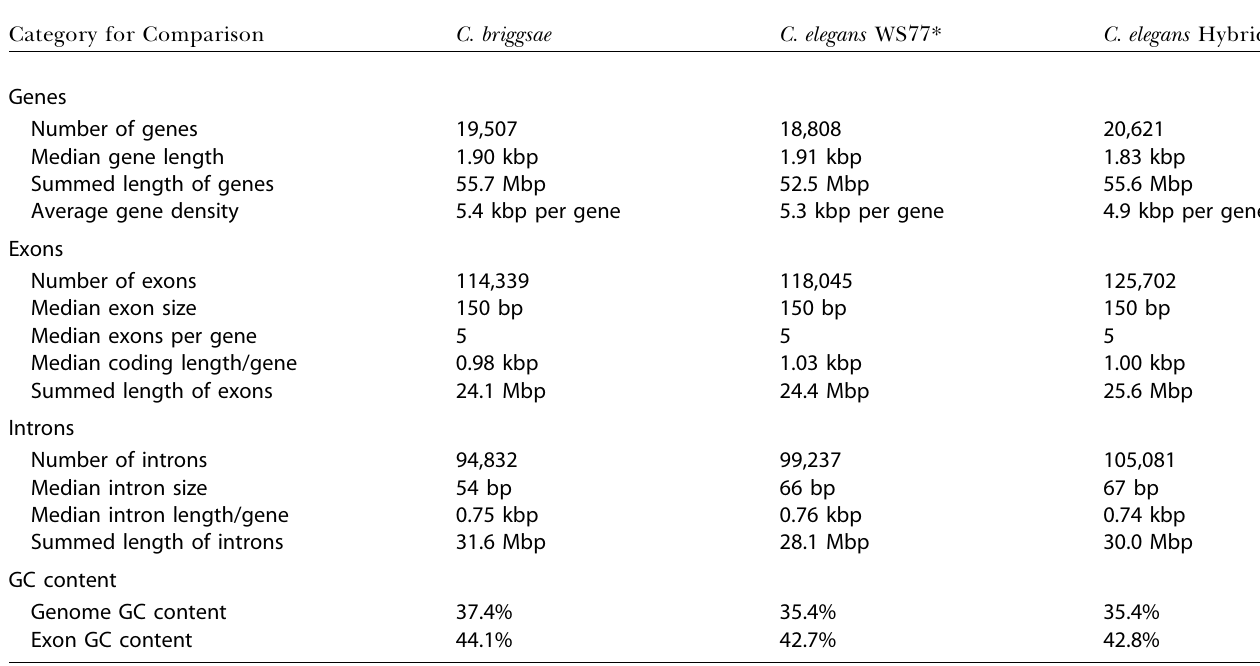
Table 1. Comparison of the C. briggsae and C. elegans Protein-Coding Gene Sets Category for